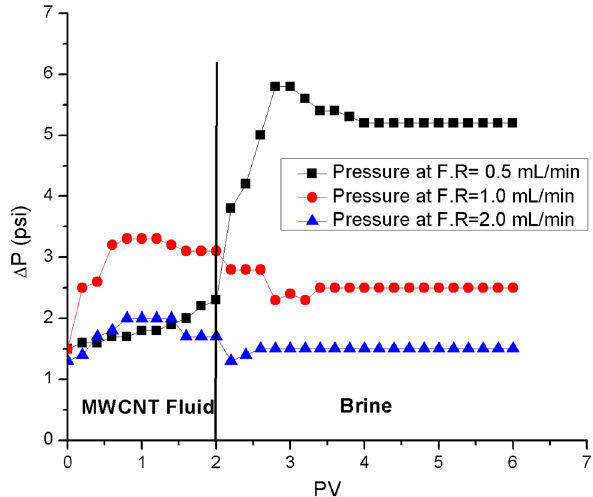
Fig. 2 Comparison of the difference in the pressure versus pore vol- ume of MWCNT fluid injected in the porous